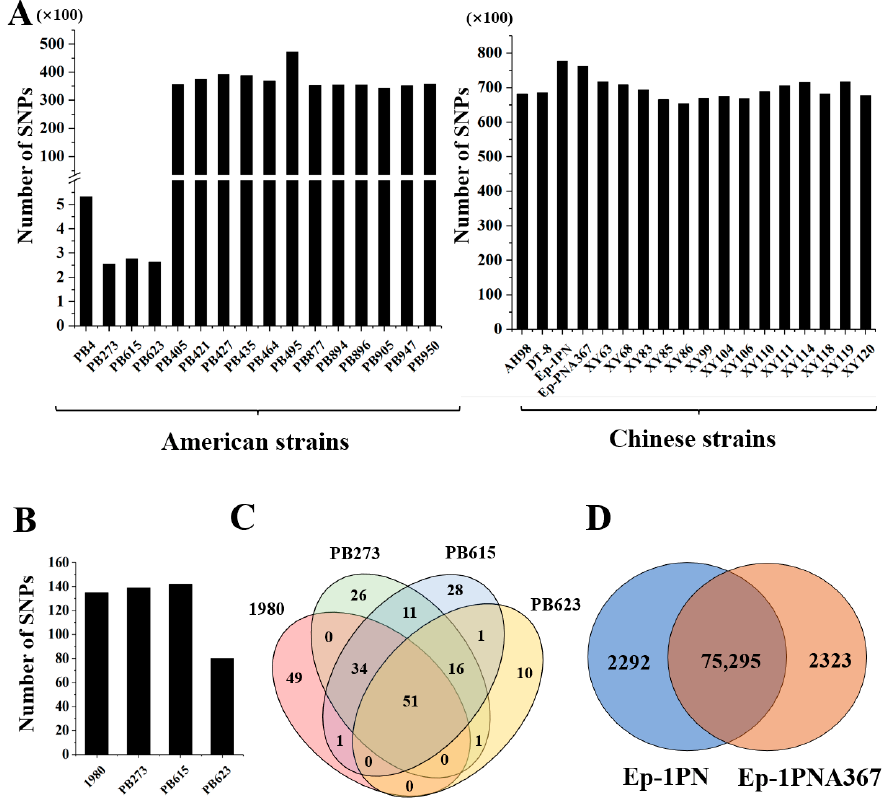
Figure 3. The genomic variation analysis of all S. sclerotiorum strains in this study. ( A ) The number of single nucleotide polymorphism (SNP) in all American and Chinese S. sclerotiorum strains compared with the genome of strain 1980. ( B , C ) The number of SNP in strains 1980, PB273, PB615 and PB623 compared with the genome of strain PB4. ( D ) The number of SNP in strains Ep-1PN and Ep-1PNA367 compared with strain 1980.